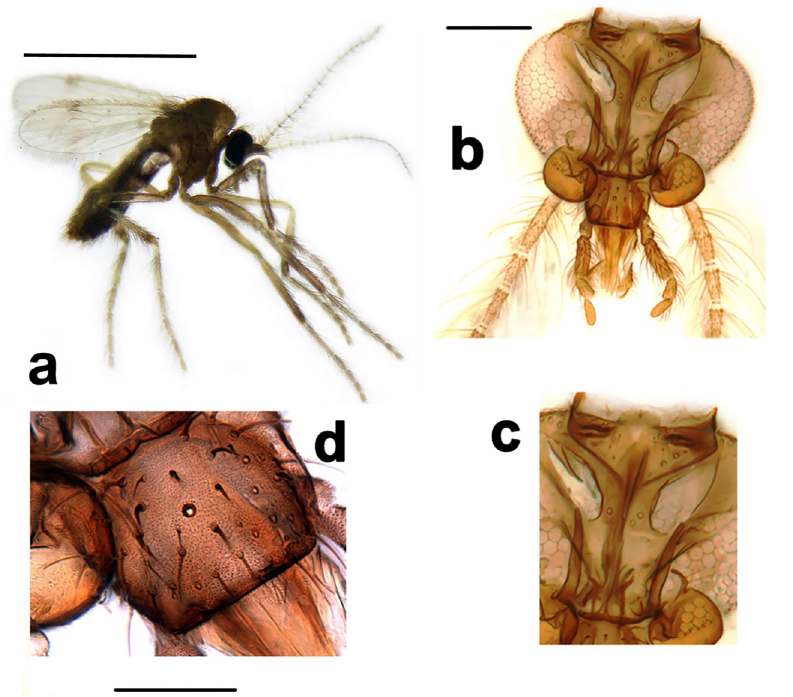
Fig. 5. Microphotography of Corethrella ielemdei. Feijó, Ramires, Lima & Pessoa sp. nov., ♀, (ILMD 0001 – 51). a . Habitus. b . Head. c . Head with coronal suture elongate. d . Clypeus. Scale bars: a = 1 mm; b = 100 μm; c– d = 50